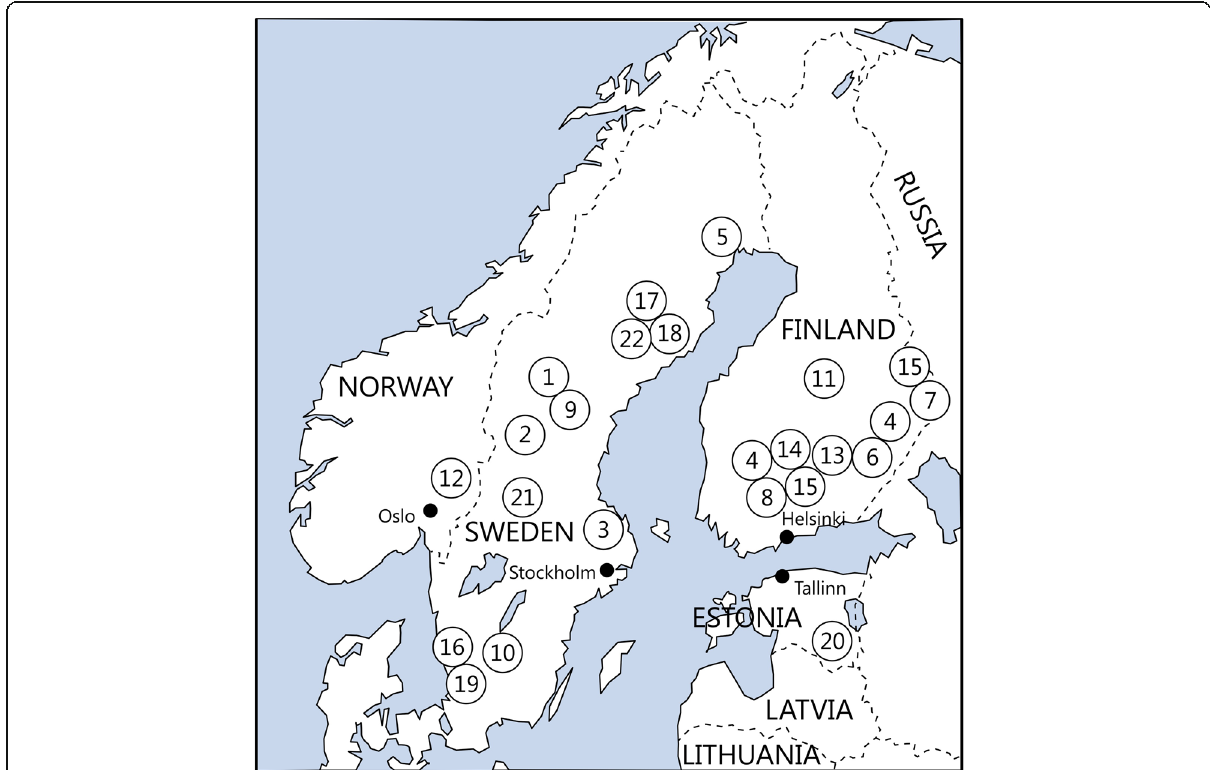
Fig. 1 Geographic locations of reviewed experiments (compare Table 1). Numbers refer to experiments as follows: 1 NaturKultur; 2 Härjedalen; 3 Fagerön; 4 MONTA (western and eastern areas); 5 Snöberget; 6 RETREE; 7 FIRE; 8 EVO; 9 Medelpad-Ångermanland; 10 Oak forest; 11 Deadwood